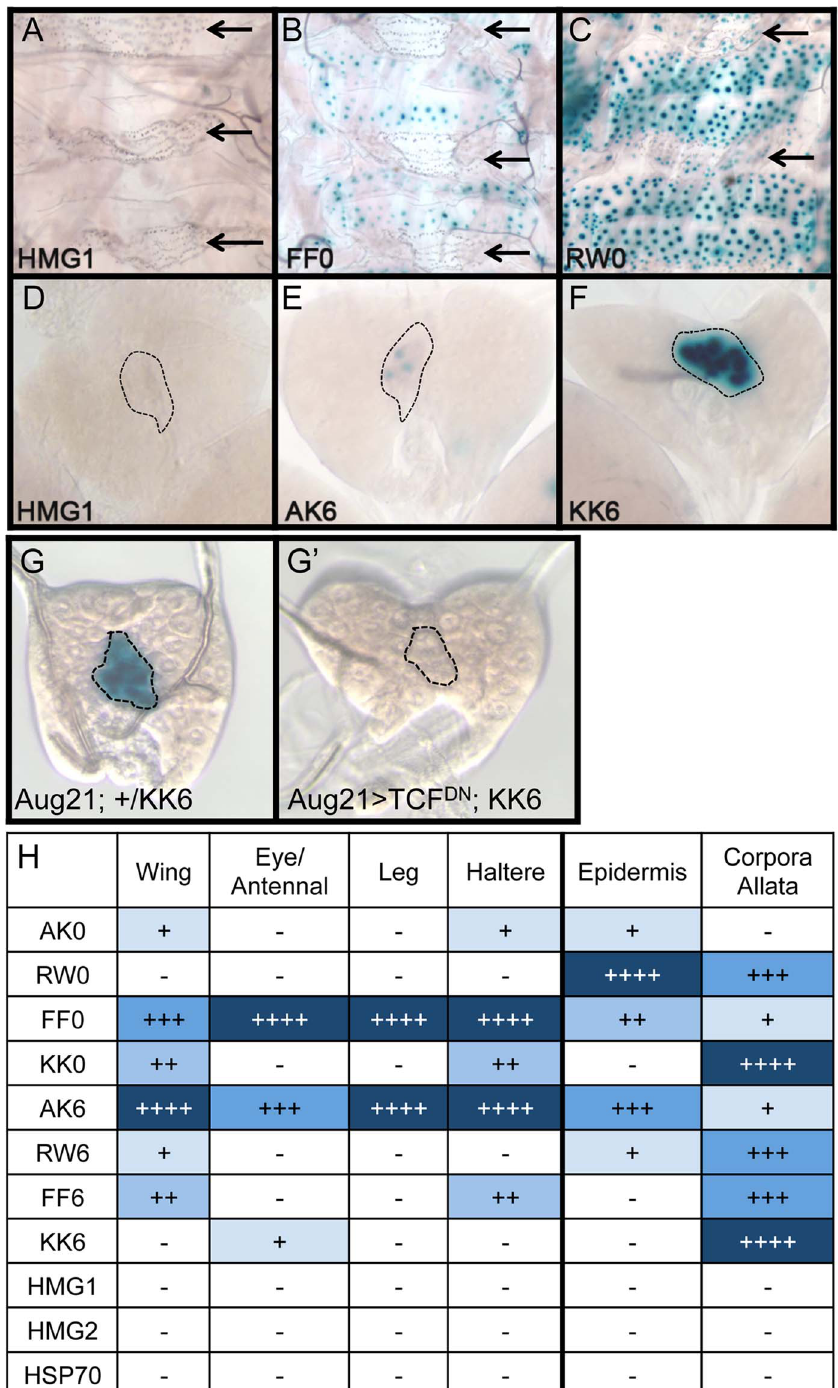
Figure 5. Tissue-specific activity of HMG-Helper pair reporters. Brightfield images of tissues from 3 rd instar larva containing the indicated lacZ reporter constructs stained for lacZ activity. (A–C) LacZ expression in larval epidermis. Expression is seen in cells underlying the naked cuticle, located between denticle belts (arrows). The HMG1 reporter has no detectable expression; FF0 has weak expression and RW0 drives robust expression. (D–F) Ring glands with expression in the Corpora Allata (dotted lines). HMG1 has no detectable expression with AK6 and KK6 displaying weak and strong expression, respectively. (G–G 9 ) Expression of TCF DN in the CA (via the Aug21Gal4 driver) abolishes expression of the KK6 reporter. (H) Summary of expression data from all tissues examined, with number of plus signs and blue hue indicative of the relative level of reporter gene expression. At least 12 samples of each reporter line were analyzed for each tissue, with similar results observed between individual samples.